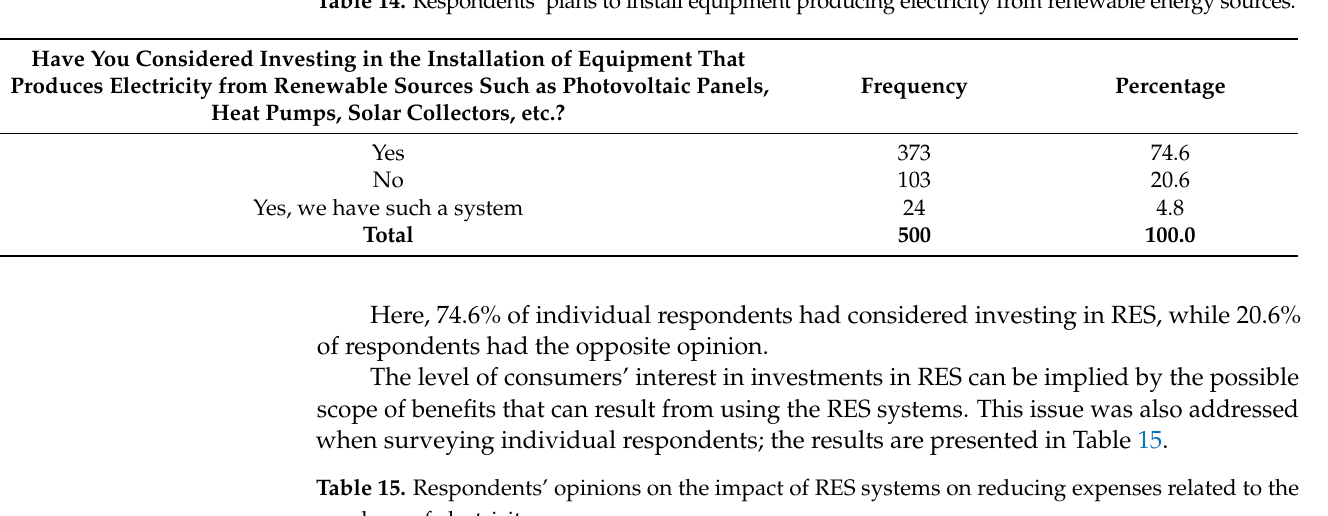
Table 14. Respondents’ plans to install equipment producing electricity from renewable energy sources.